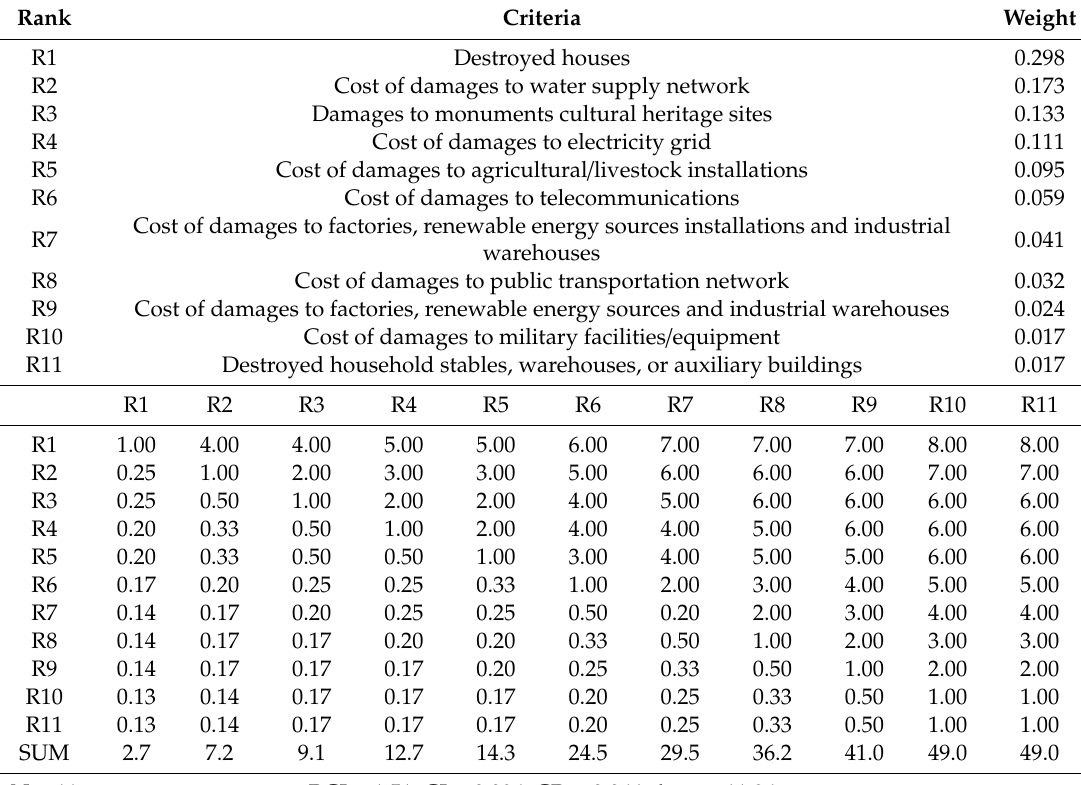
Table A13. Pair-wise comparison reciprocal matrix for the destruction and damages to infrastructure fire e ff ects category. RCI: random consistency index; CI: consistency index; CR: consistency ratio; λ max : principal eigenvalue.